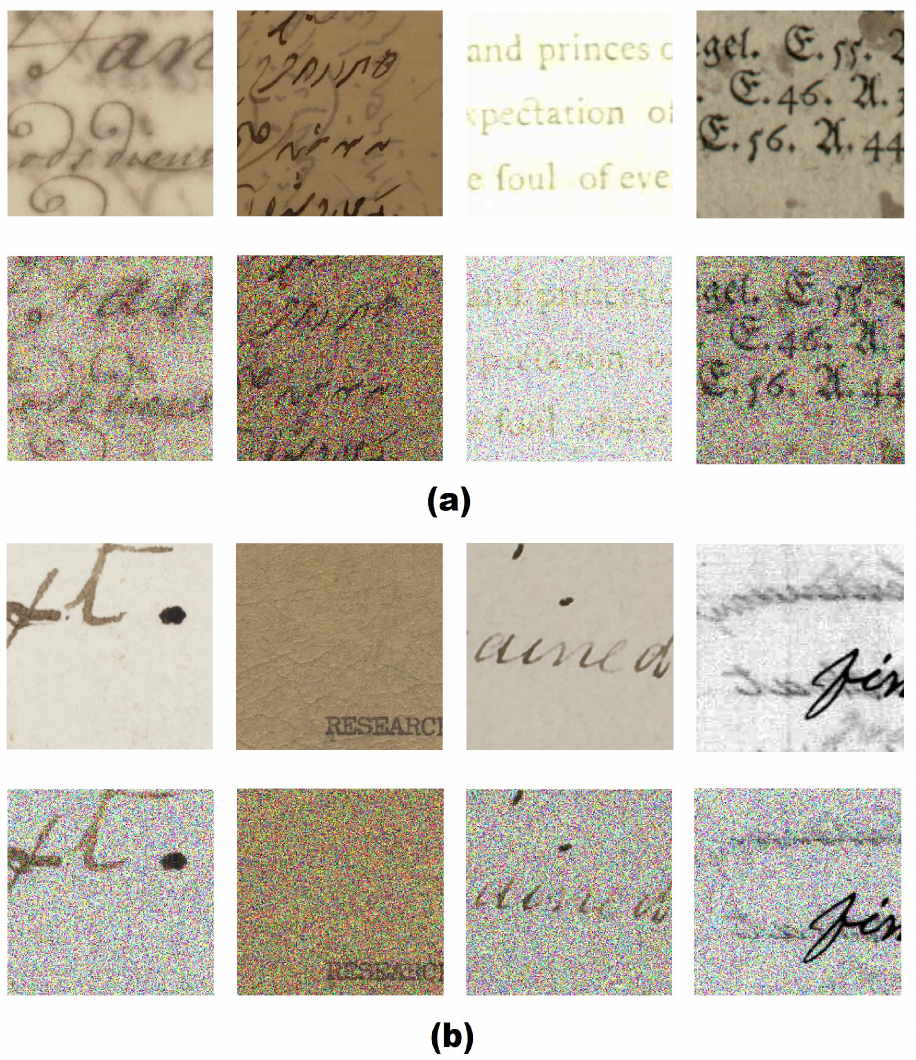
Figure 6. Example of images with heavy noise [24–32], where: ( a ) the document image suffered from zero-mean Gaussian noise (bottom), and ( b ) the document image suffered from speckle noise